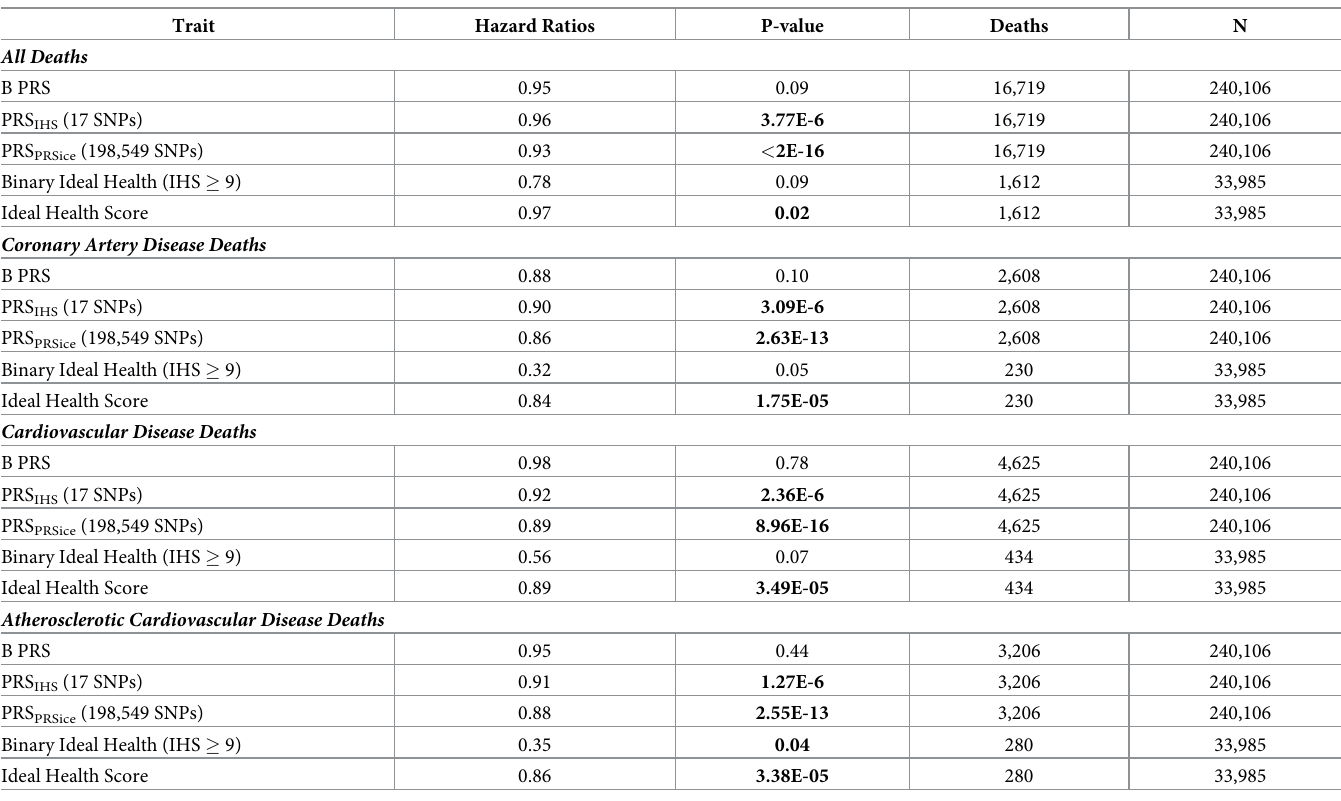
Table 5. Cox regression and competing risk analysis of mortality outcomes.